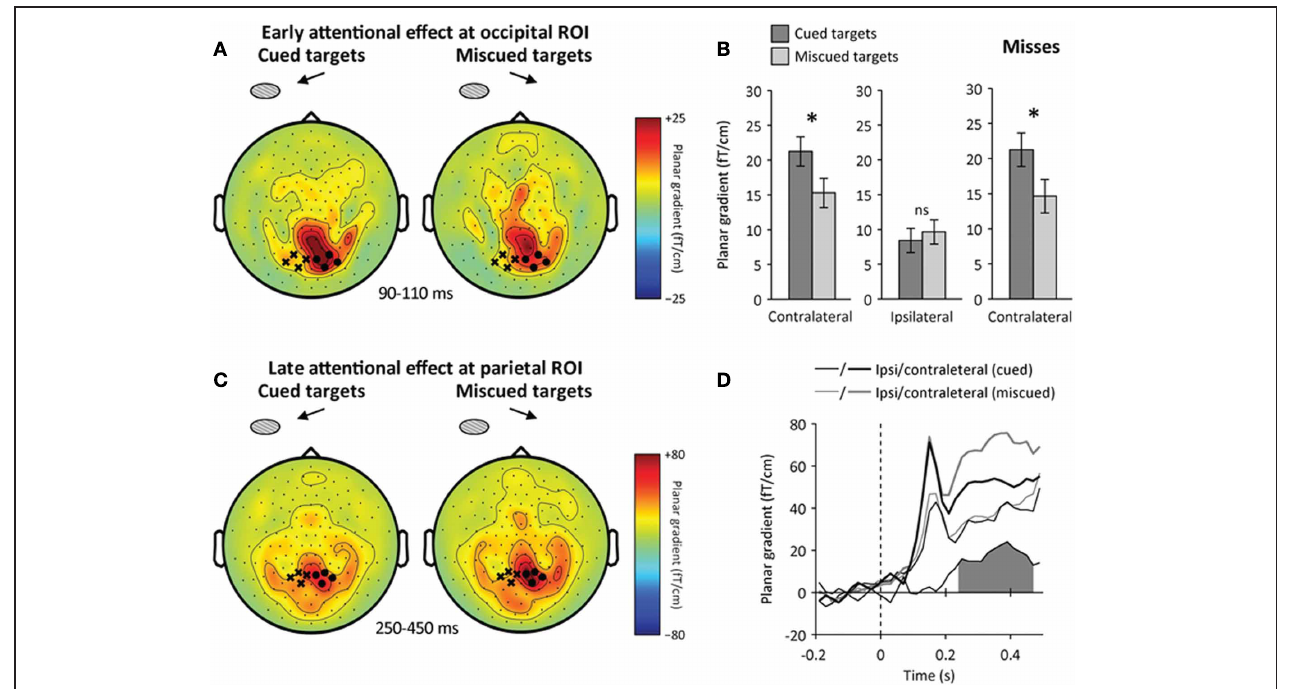
FIGURE 4 | Neural correlates of spatial attention following target onset. (A) Early attentional enhancement at occipital ROI. Sensor-level topography of early neuromagnetic event-related signals at 90–110ms following target onset (left: cued targets, right: miscued targets). The contralateral (ipsilateral) occipital ROI is indicated by black dots (cross, respectively). The contralateral occipital response was increased for cued relative to miscued targets. (B) Early attentional amplification of the contralateral occipital response to cued (dark) relative to miscued (light) targets. Error bars indicate within-subject s.e.m. A star indicates a significant effect ( p < 0 . 05), ns a non-significant effect. Spatial attention enhanced the contralateral (left), but not the ipsilateral (center) occipital response. Right: spatial attention significantly enhanced the contralateral occipital response to missed targets.